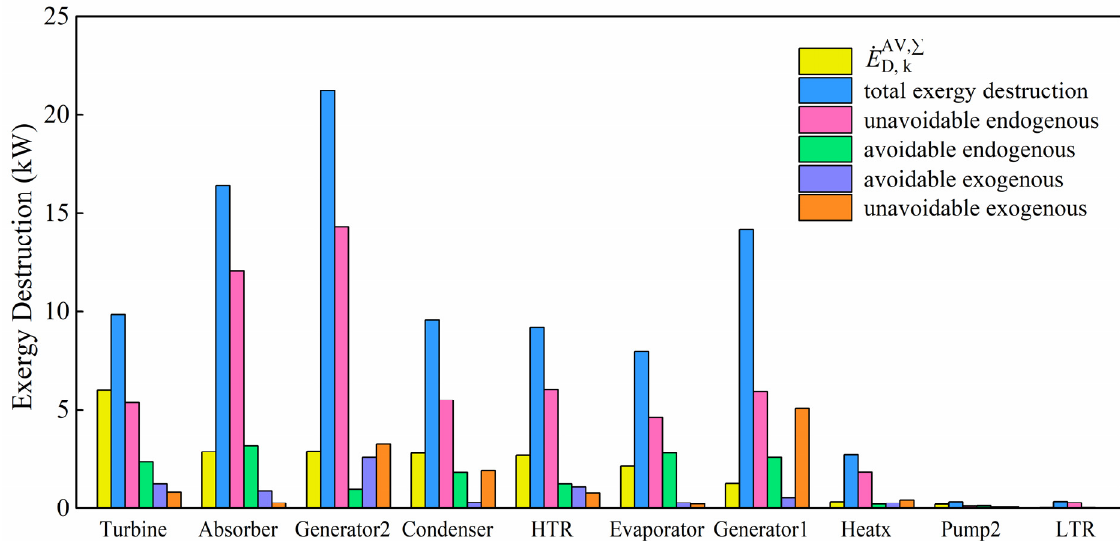
Figure 7. Improvement potential and detailed exergy destruction. There are several important criteria for evaluating all the considered components and the whole system, including thermal efficiency and exergy destruction of the overall system (as shown in Figure 8), exergy efficiency, exergy destruction ratio, modified exergy efficiency, modified exergy destruction ratio and EIP (as given in Table 7). In the real condition, the thermal efficiency of this integrated system is 16.78%, with overall exergy destruction of 93.02 kW. The corresponding values are 19.57% and 61.26 kW for the unavoidable condition, and 21.39% and 51.80 kW for the ideal condition. When the integrated system operates in the improved conditions of the unavoidable and ideal cycles, the waste heat is recovered and utilized with higher efficiency. Additionally, the overall exergy destruction dramatically decreases.